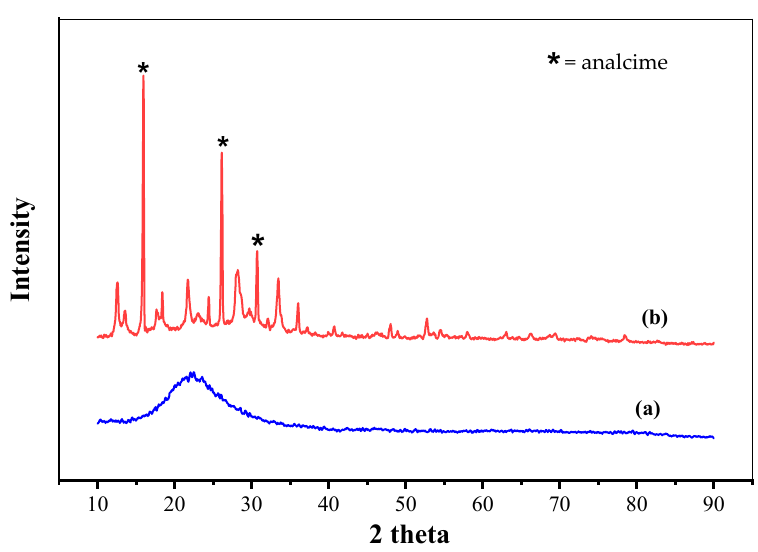
Figure 1. Diffractogram of (a) geothermal waste and (b) synthesized zeolite from geothermal waste. Figure 1. Di ff ractogram of ( a ) geothermal waste and ( b ) synthesized zeolite from geothermal